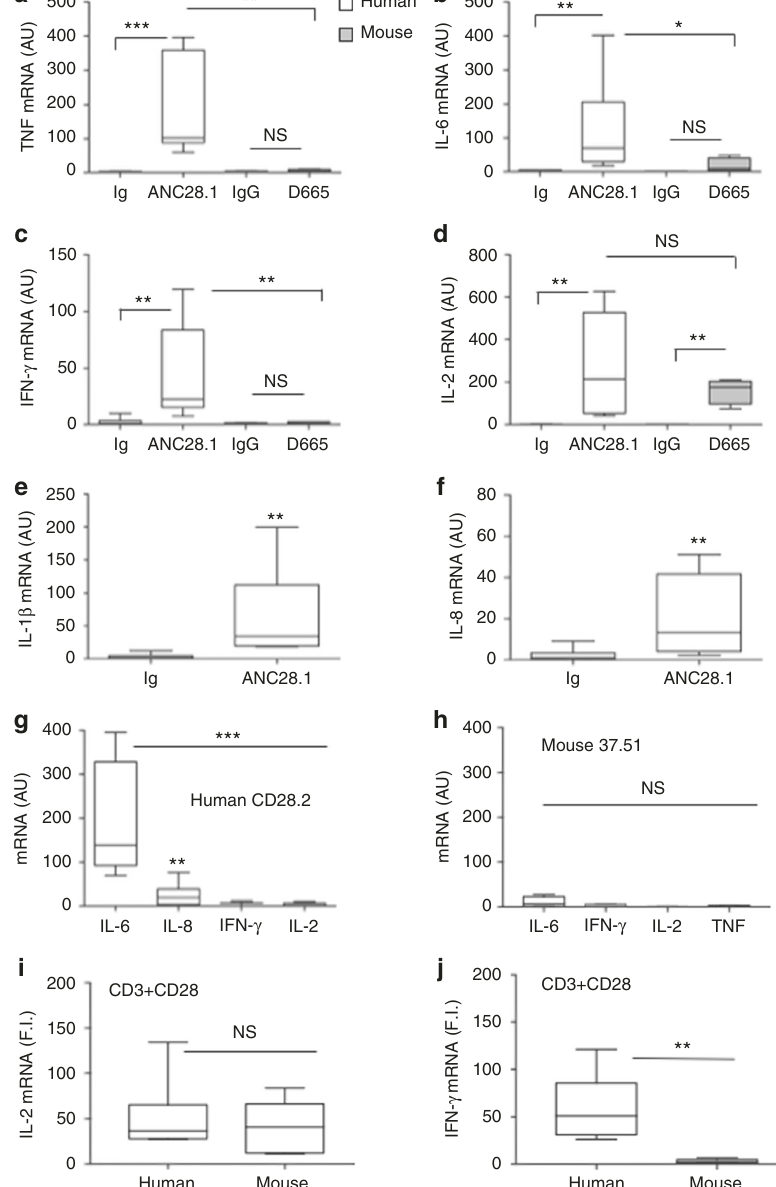
Fig. 1 CD28 stimulation strongly upregulates pro-in fl ammatory cytokine and chemokine gene expressions in human but not in mouse CD4 + T cells. mRNA levels of splenic CD4 + T cells from n = 13 mice or human peripheral blood CD4 + T cells stimulated for 1 h or 6 h with 2 μ g ml − 1 isotype control mAb (Ig) or crosslinked agonistic Abs (human CD28.2 or mouse 37.51) or CD28SAbs (human ANC28.1 or mouse D665), or anti-CD3 (human UCHT1 or mouse 145- 2C11) plus anti-CD28 (human CD28.2 or mouse 37.51) Abs. a TNF (1 h stimulation). b IL-6 (1 h stimulation). c IFN- γ (1 h stimulation). d IL-2 (6 h stimulation). e IL-1 β (1 h stimulation). f IL-8 (6 h stimulation). Median values: TNF ( n = 7), ANC28.1 = 102.3 vs. D665 = 2.77; IL-6 ( n = 6), ANC28.1 = 69.7 vs. D665 = 8.5; IFN- γ ( n = 7), ANC28.1 = 22.5 vs. D665 = 1.94; IL-2 ( n = 6), ANC28.1 = 214 vs. D665 = 176; IL-1 β ( n = 6), ANC28.1 = 34.0; IL-8 ( n = 6), ANC28.1 = 13.1. g IL-6 ( n = 8, median = 138.9), IL-8 ( n = 9, median = 19.5), IFN- γ ( n = 3, median = 6.8), and IL-2 ( n = 5, median = 1.1) mRNAs levels upon 6 h stimulation of human CD4 + T cells with isotype control Ig or crosslinked human CD28.2. h IL-6 (median = 6.6), IFN- γ (median = 4.3), IL-2 (median = 0.8), and TNF (median = 2.6) mRNAs levels upon 6 h stimulation of murine CD4 + T cells with isotype control Ig or crosslinked mouse 37.51. i Human IL-2 ( n = 8, median = 36.6) and mouse IL-2 (median = 40.8), j human IFN- γ ( n = 7, median = 51.1) and mouse IFN- γ (median = 2.4) mRNA levels upon 6 h stimulation of CD4 + T cells with isotype control Ig or crosslinked anti-CD3 plus anti-CD28 Abs. All mRNAs were measured by real-time PCR and values, normalised to GAPDH (human) or RLP32 (mouse), expressed as arbitrary units (AU) or fold induction (F.I.). Lines represent median values and statistical signi fi cance was calculated by Mann – Whitney test. Asterisks indicate * p <0.05, ** p <0.01, *** p <0.001, calculated on cells stimulated with isotype control